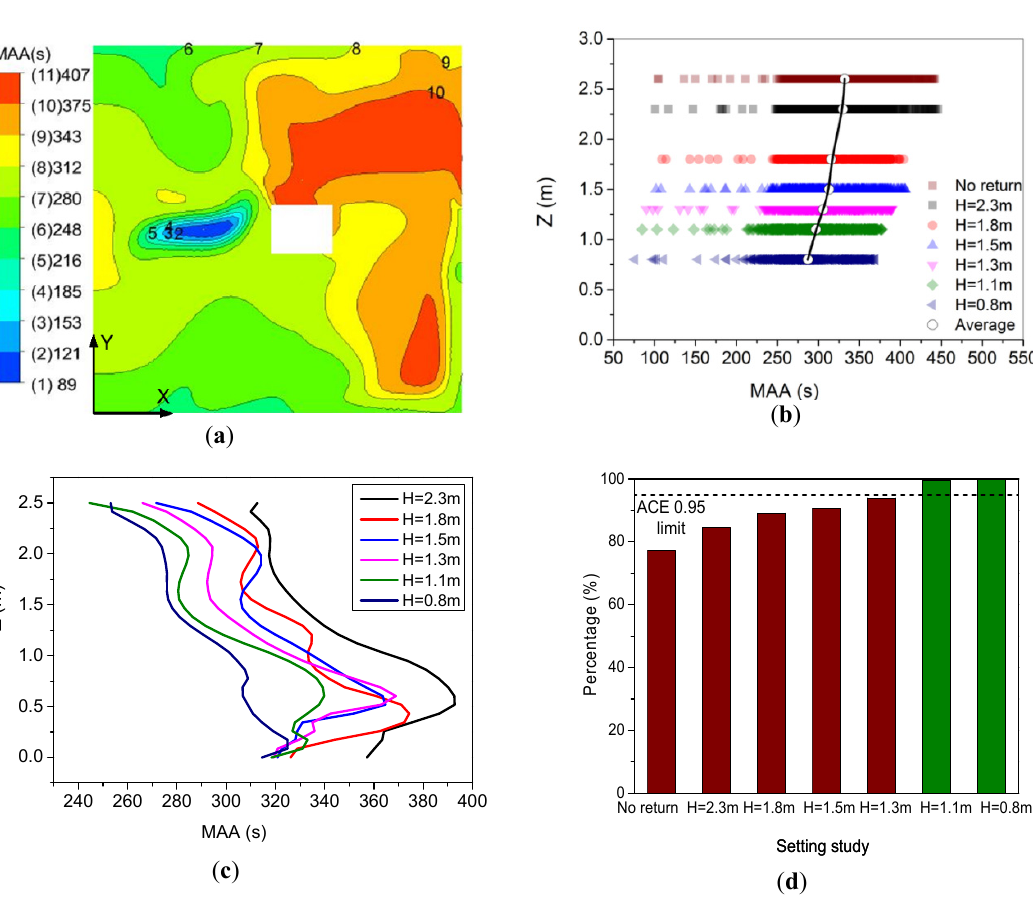
Figure 9. Draught rate (DR) index for different settings.